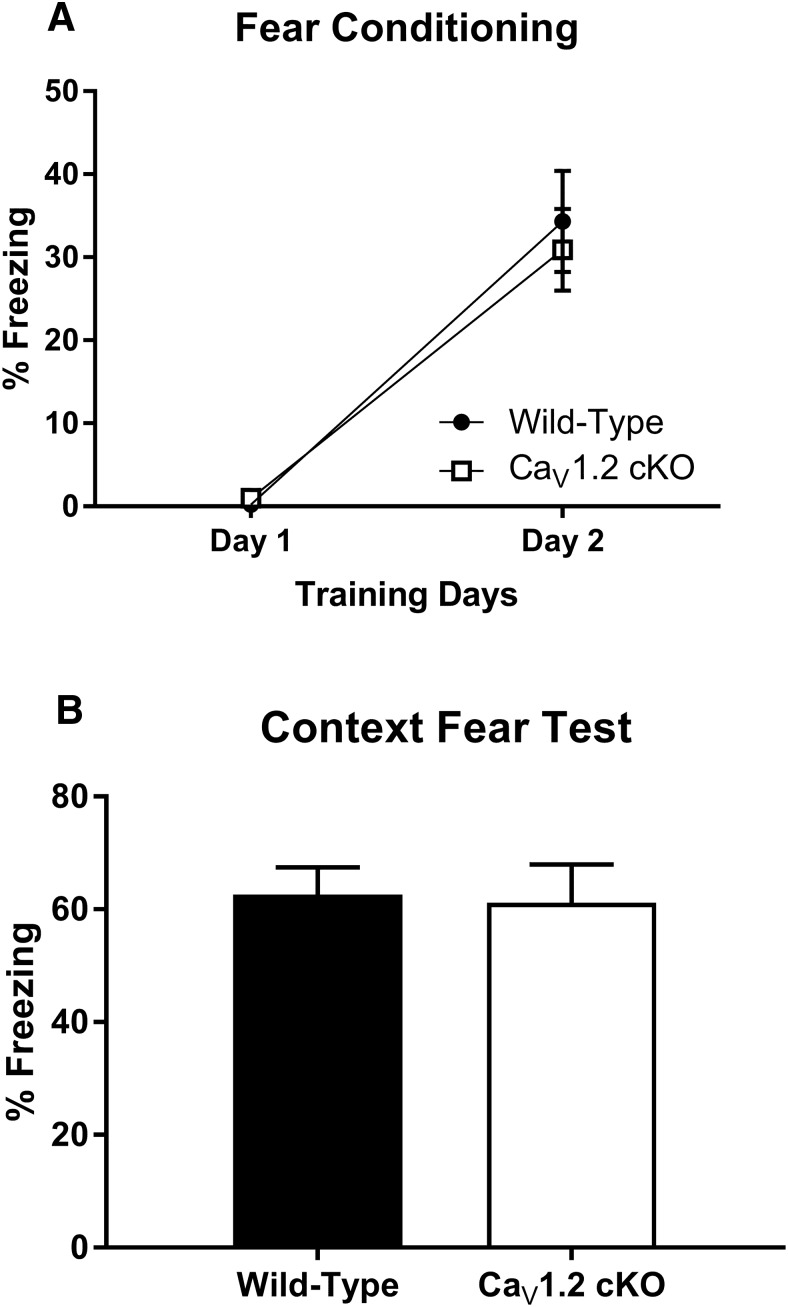
Neuronal deletion of CaV1.2 does not impair fear acquisition or consolidation to a conditioned context. Mice were fear conditioned to a context using three unsignaled footshocks per day for 2 d. A, Both CaV1.2 conditional knock-out mice (n = 17) and wild-type mice (n = 17) exhibited a significant enhancement in freezing in response to the conditioned context between days 1 and 2 of training. B, When tested for their fear of the context, CaV1.2 conditional knock-out mice exhibited high levels of freezing comparable to those of wild-type mice. Data are represented as the mean ± SEM.